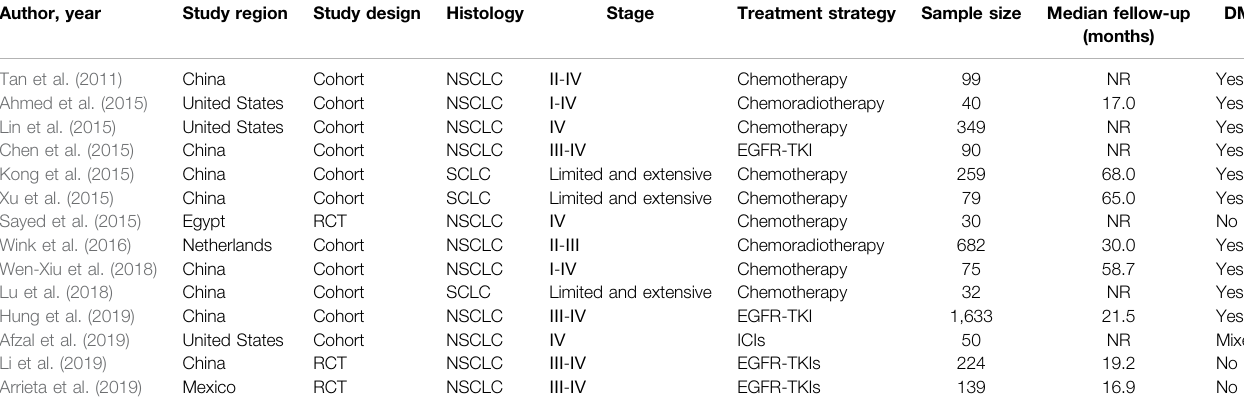
TABLE 1 | Main characteristics of included